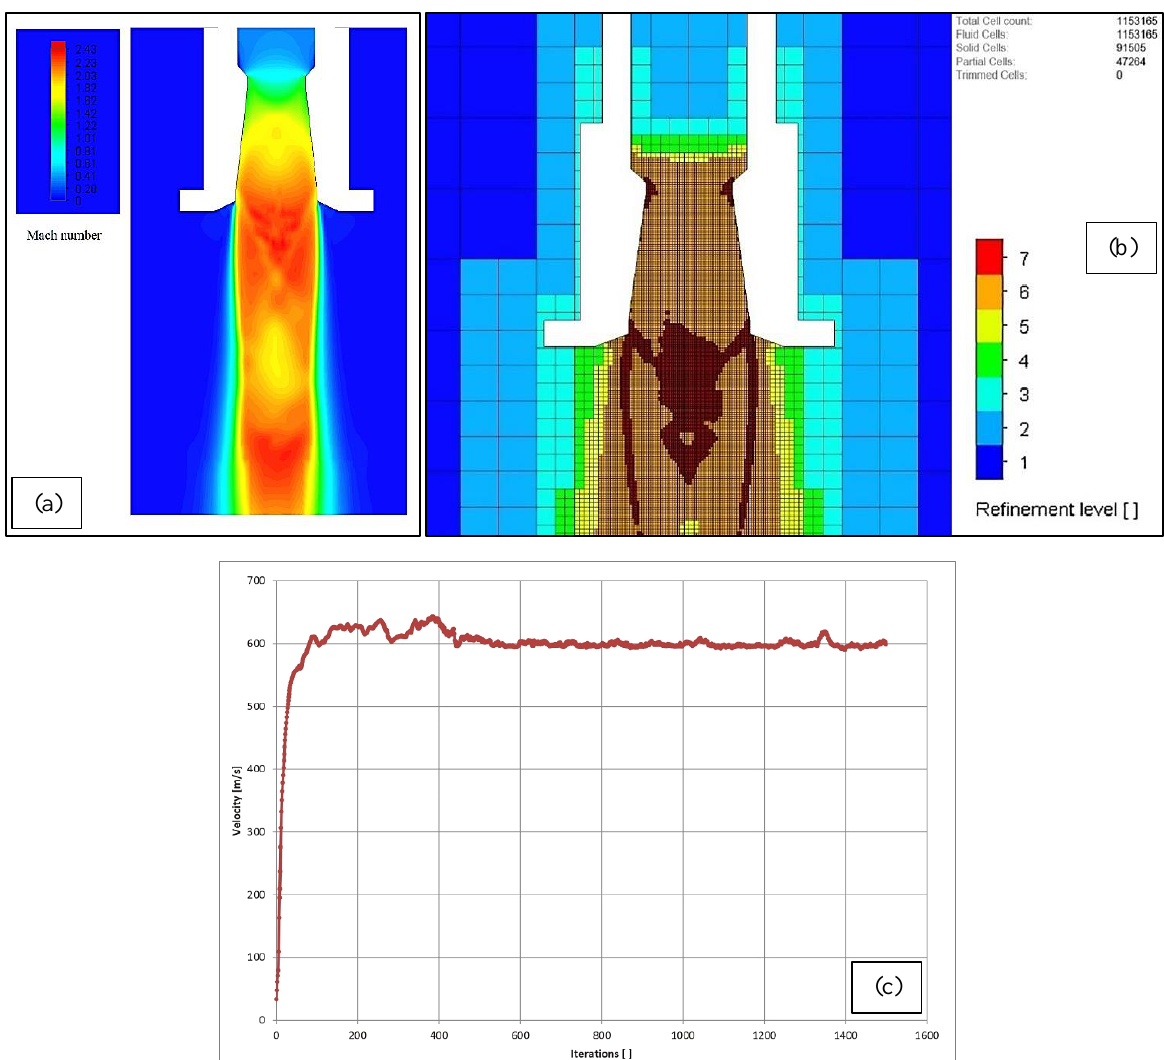
Figure 25. Gas outflow pattern with a concentric arrangement of nozzle and diaphragm: (a) calculation data; (b) A fragment of the adapted computational grid; (с) A fragment of the report on the calculation data